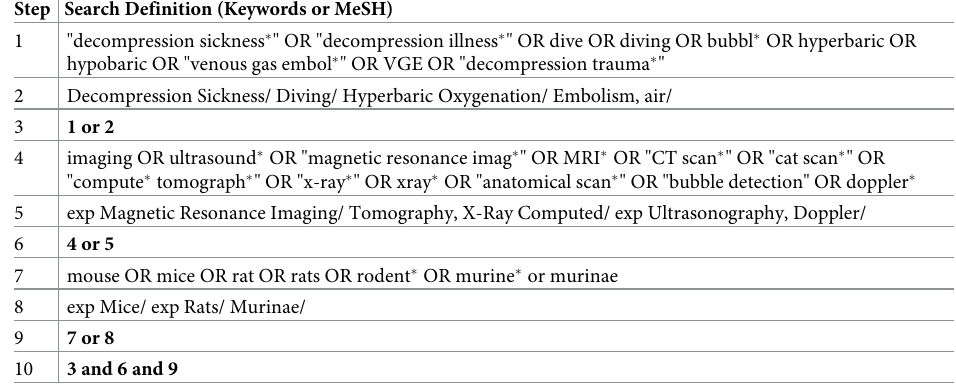
Table 4. Search methodology for